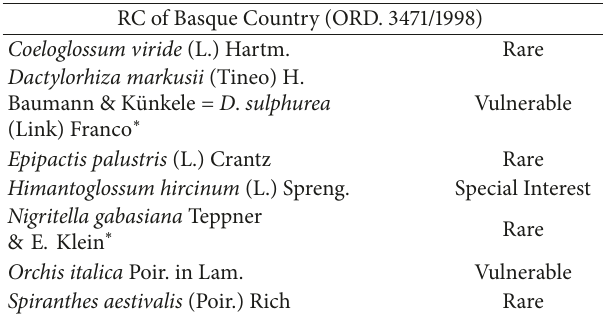
Table 3: Species included in the Red List of the Vascular Flora of Andalusia [92].